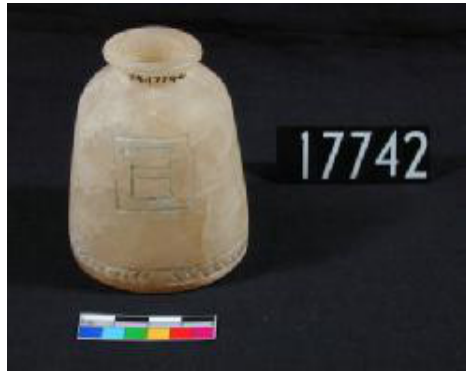
Figure 1: Alabaster vessel from prehistory era in the British